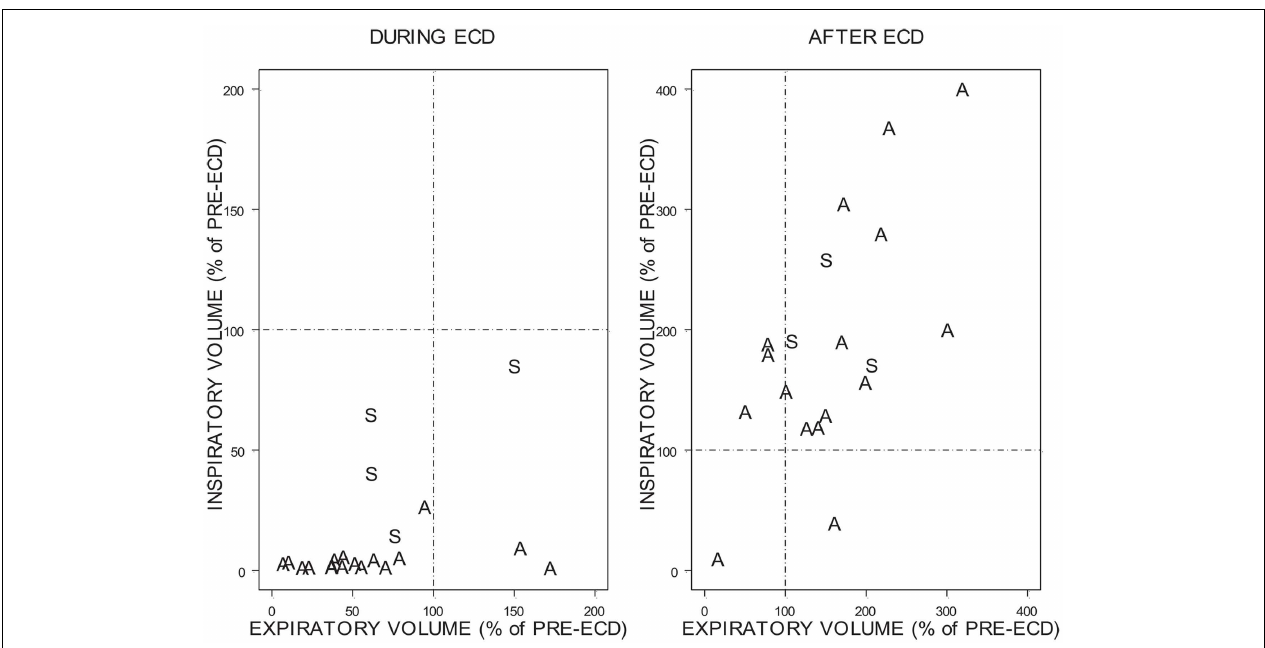
FIGURE 8 | Change in inspiratory and expiratory volume during ECD and after ECD. Due to the variability of the percentages the above figures are presented on different scales. A = Both exposure locations were above the bottom of the spine. S = Exposure locations spanned the bottom of the